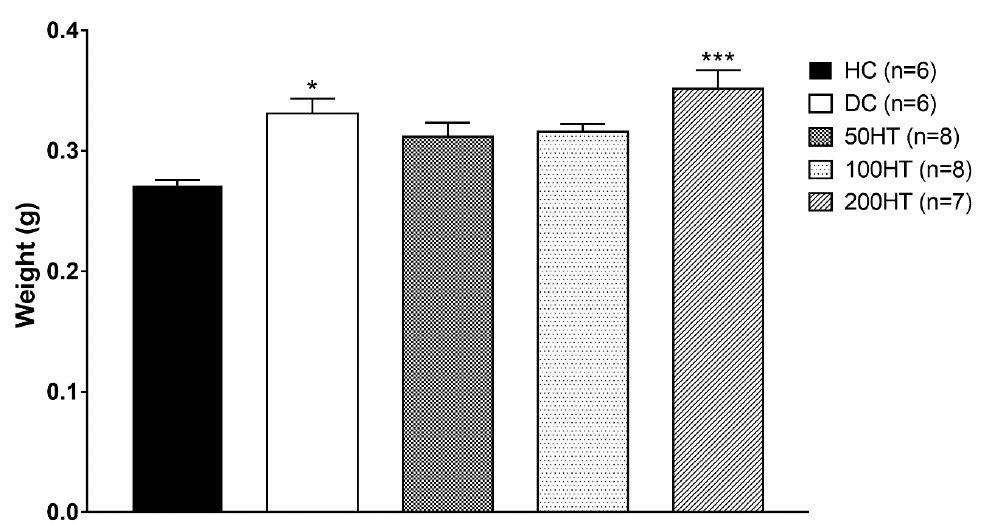
Figure 10. Effect of horsetail on heart weight index. The * and *** indicates significant difference from Figure 10. E ff ect of horsetail on heart weight index. The * and *** indicates significant di ff erence from the HC group ( p < 0.05 and p < 0.001, respectively). the HC group ( p < 0.05 and p < 0.001, respectively).